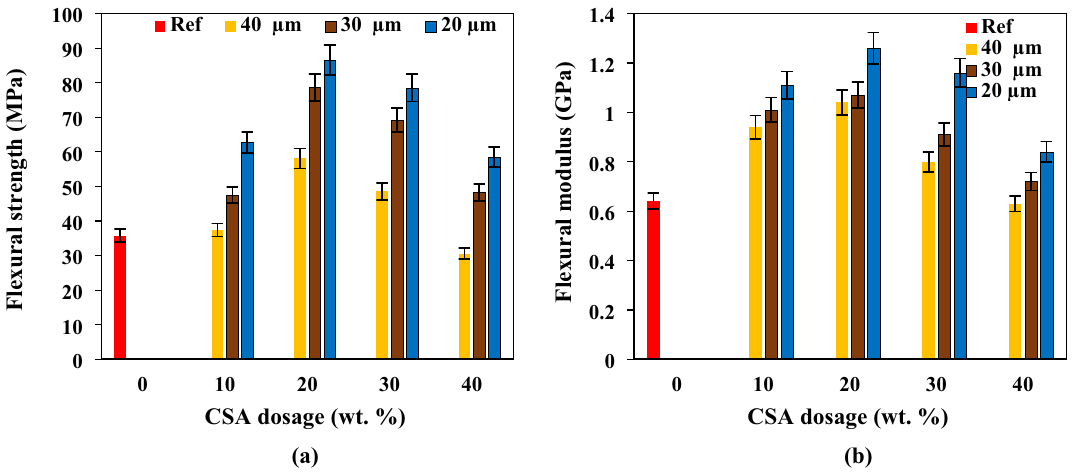
Figure 3. Influence of CSA proportion and size on ( a ) flexural strength ( b ) flexural